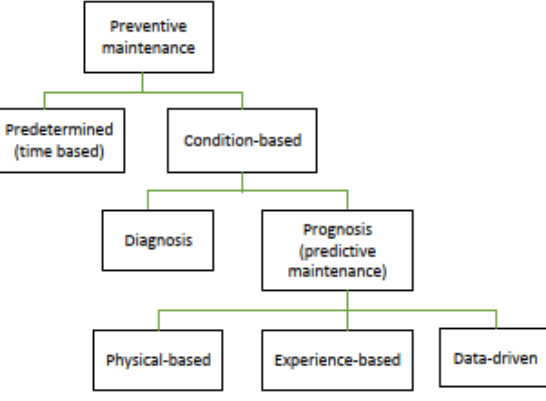
Figure 1. Taxonomy of predictive maintenance [14].